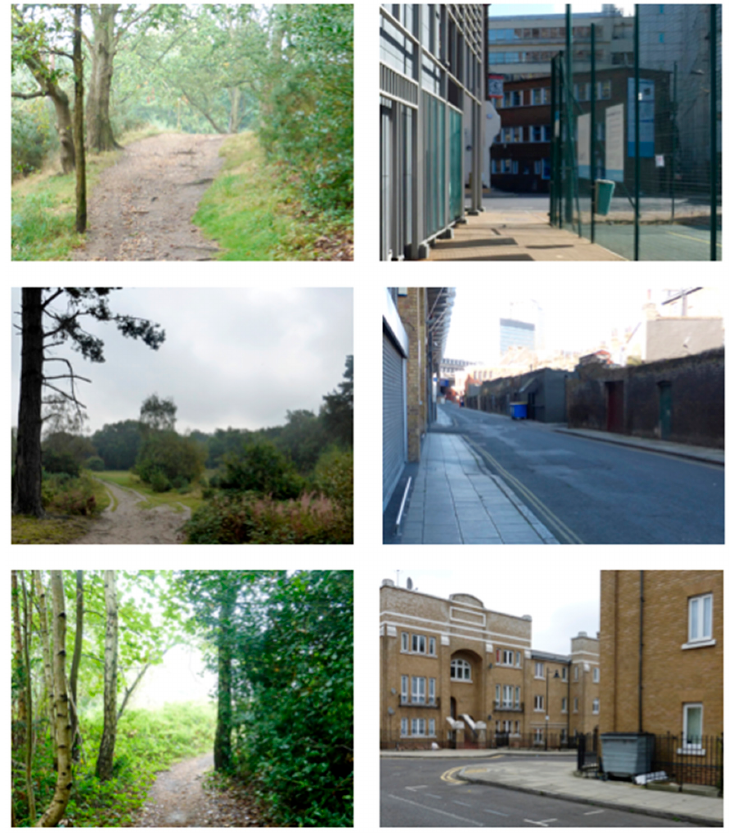
Figure 1. Sample images from natural and urban environment slideshows.